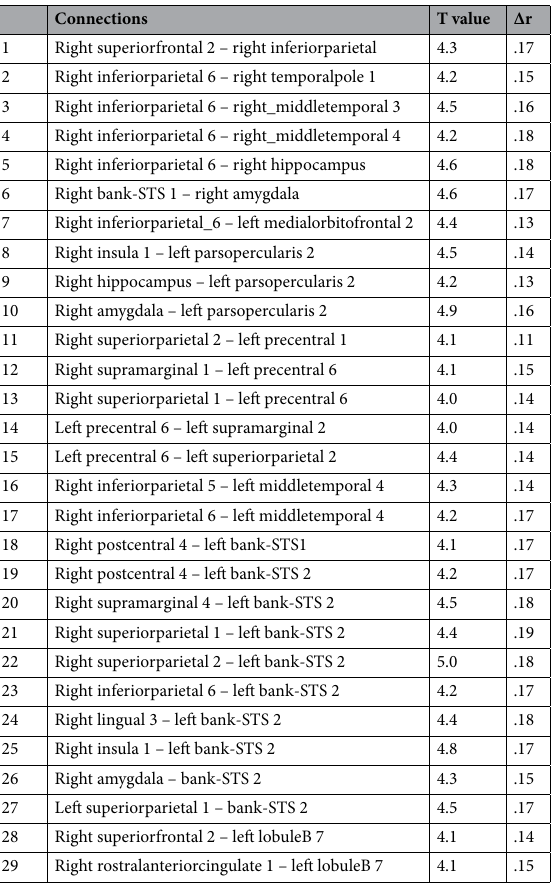
Table 5. Connections belonging to the NBS subnetwork showing increased connectivity after training compared to BL1. Numbers next to brain region refers to the Lausanne 2008 atlas. Δr reflects the group average difference of correlation between post-training and baseline for each specific connection in the